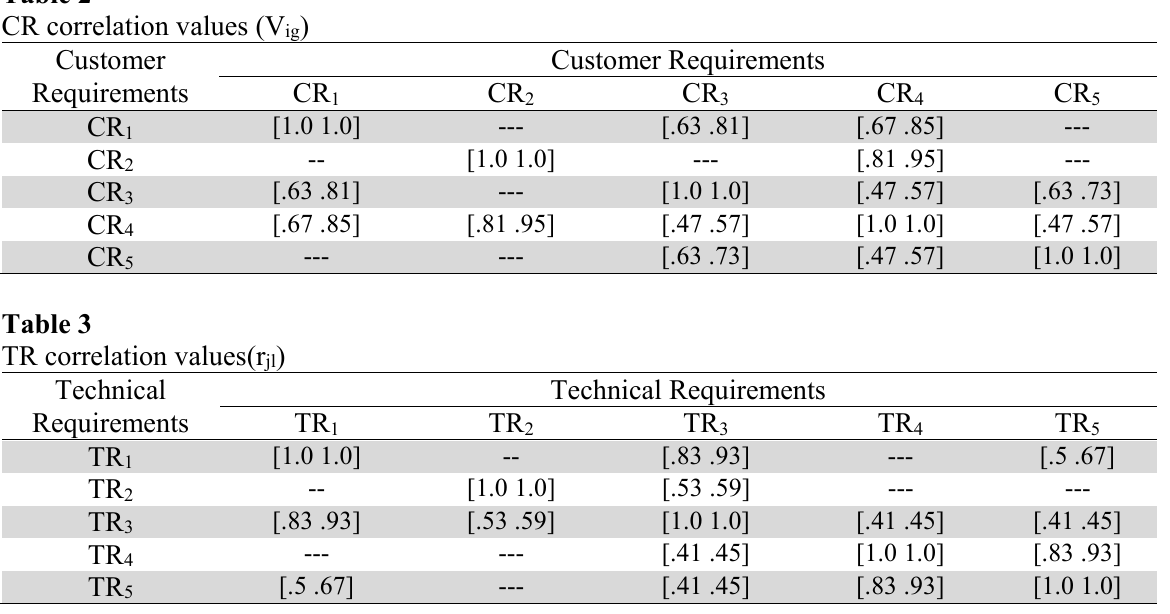
Table 4 CR-TR interrelations values and the normalized interrelation values TR 1 CRs